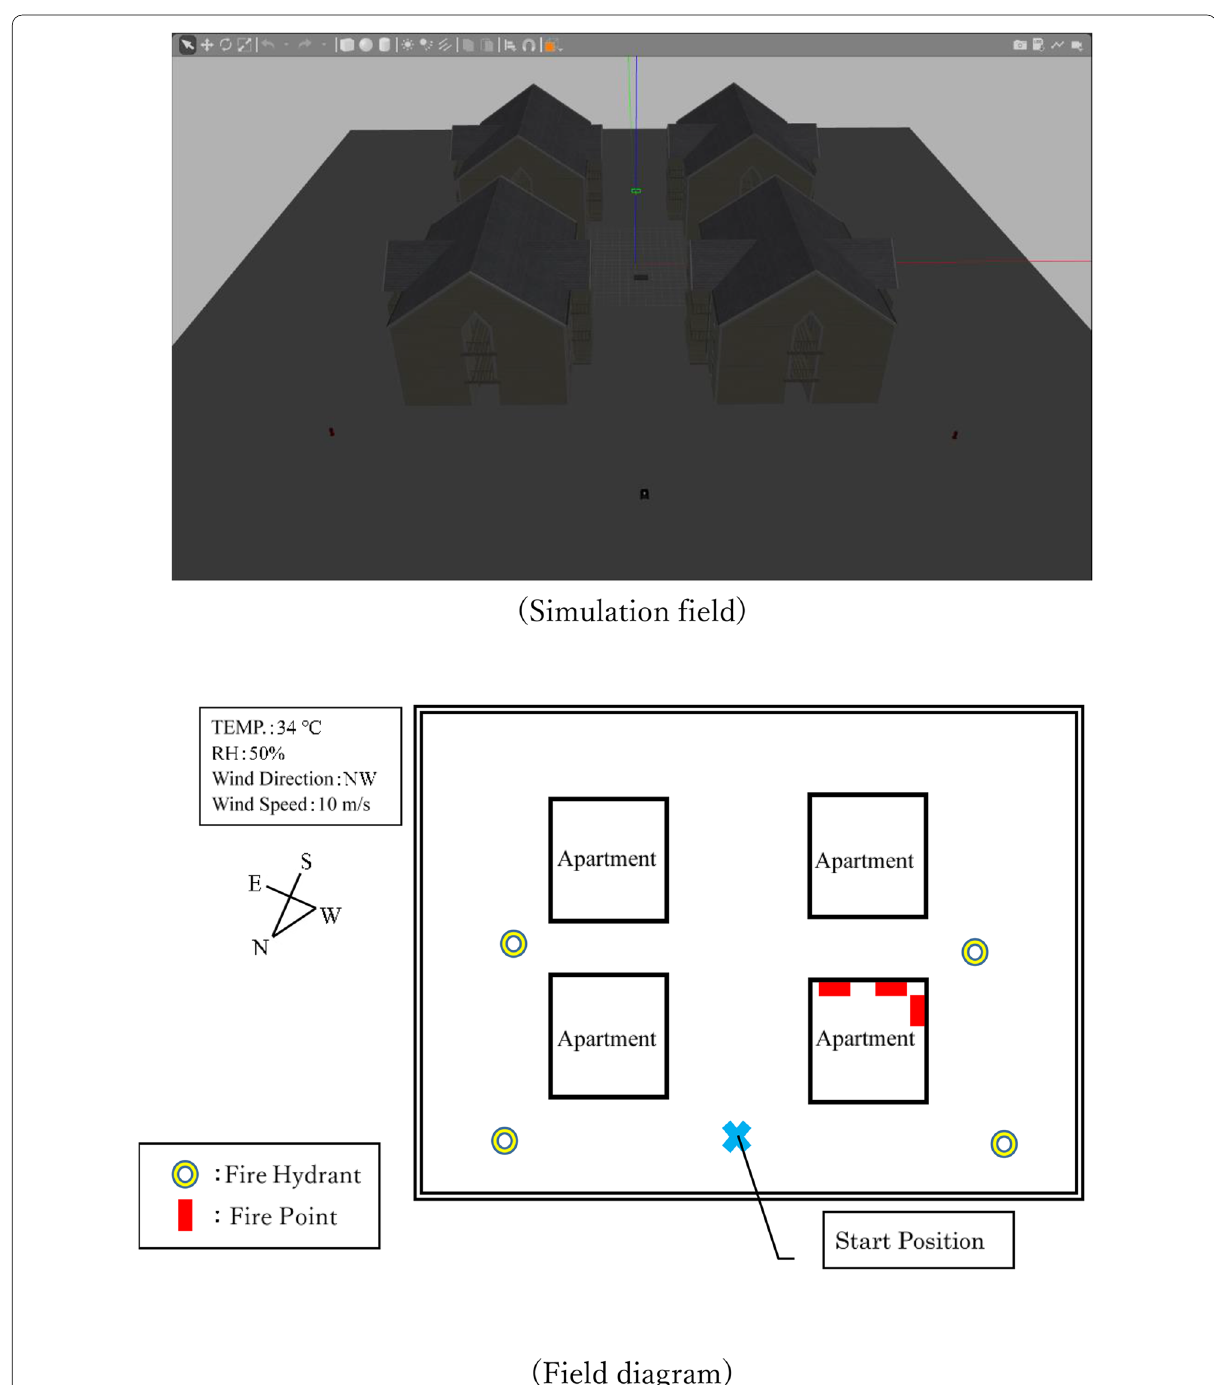
Fig. 3 Experimental field of